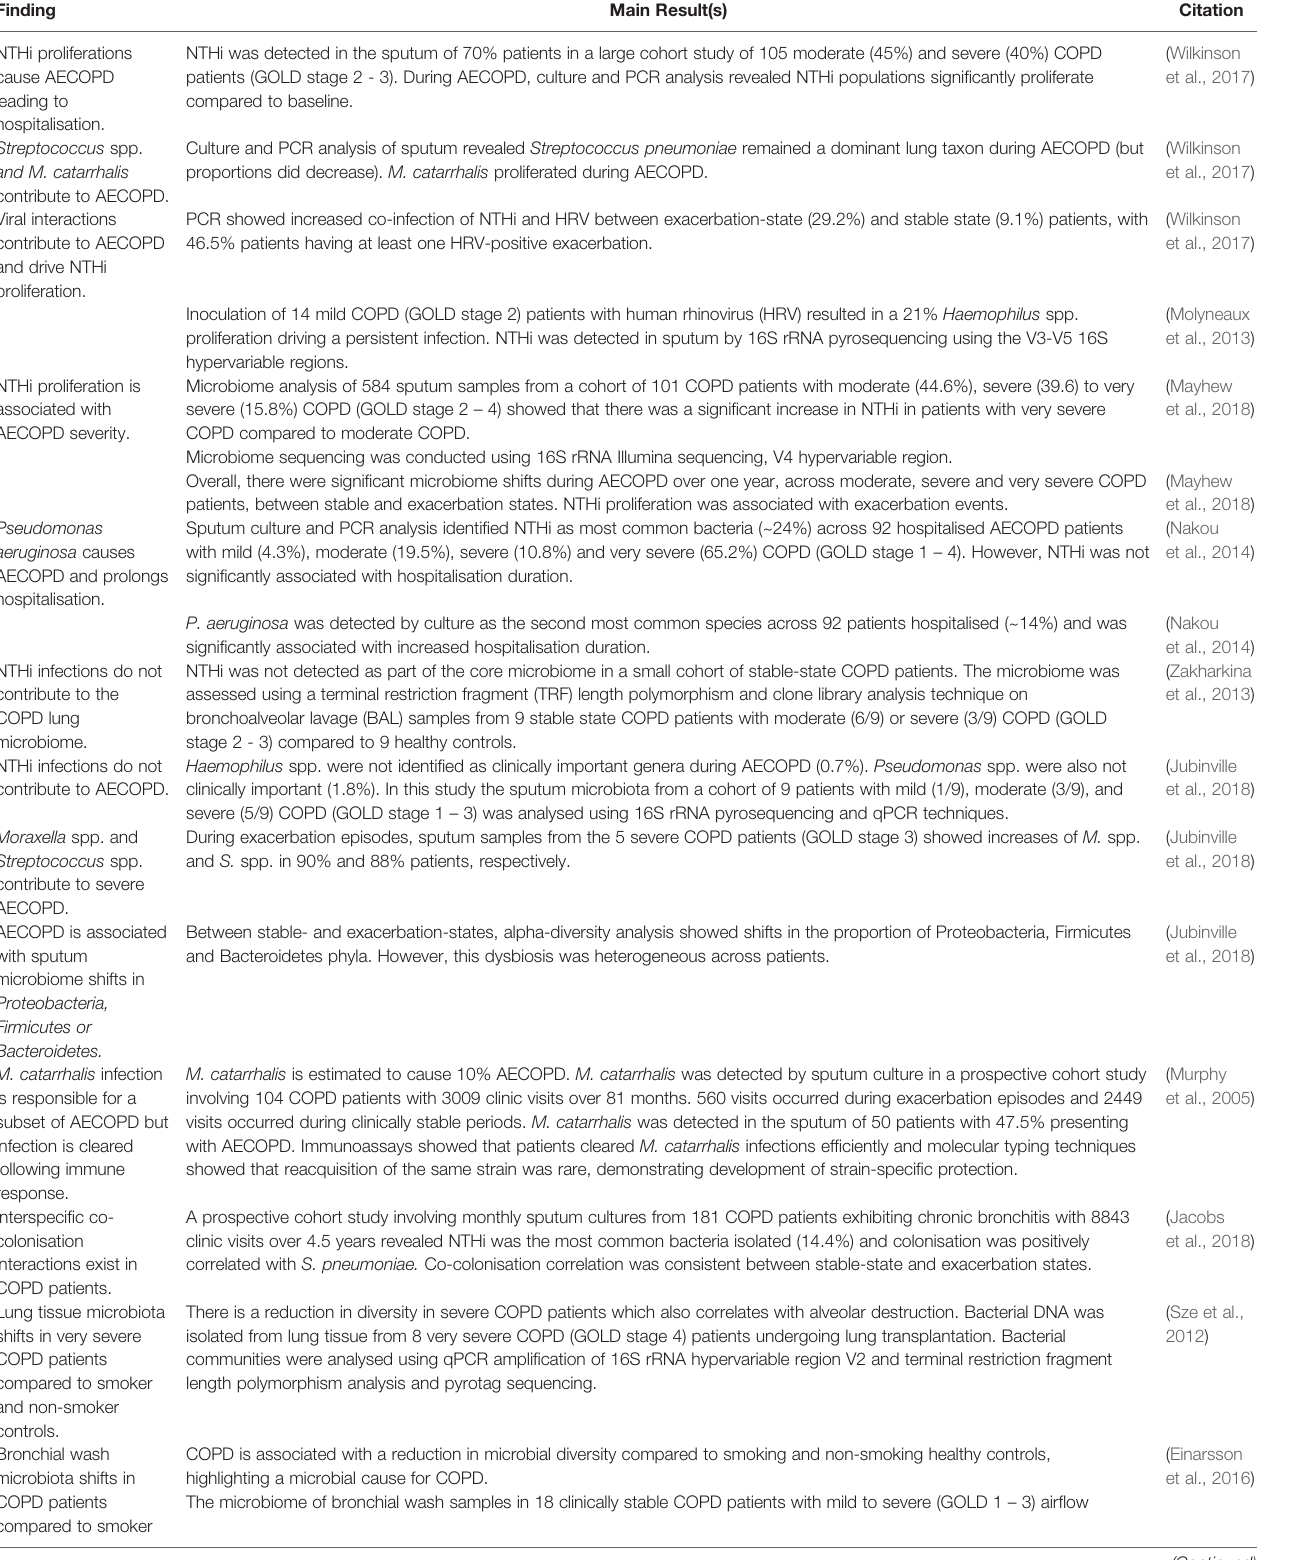
TABLE 1 | Summary of Key Studies Investigating AECOPD